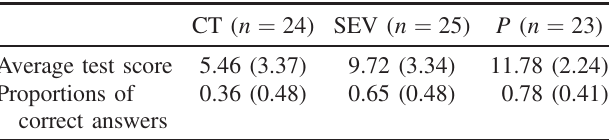
TABLE V. Average test scores and proportions of correct answers across groups; standard deviations are given in paren- theses. Theoretically, the test-score scale ranges from 0 to 15